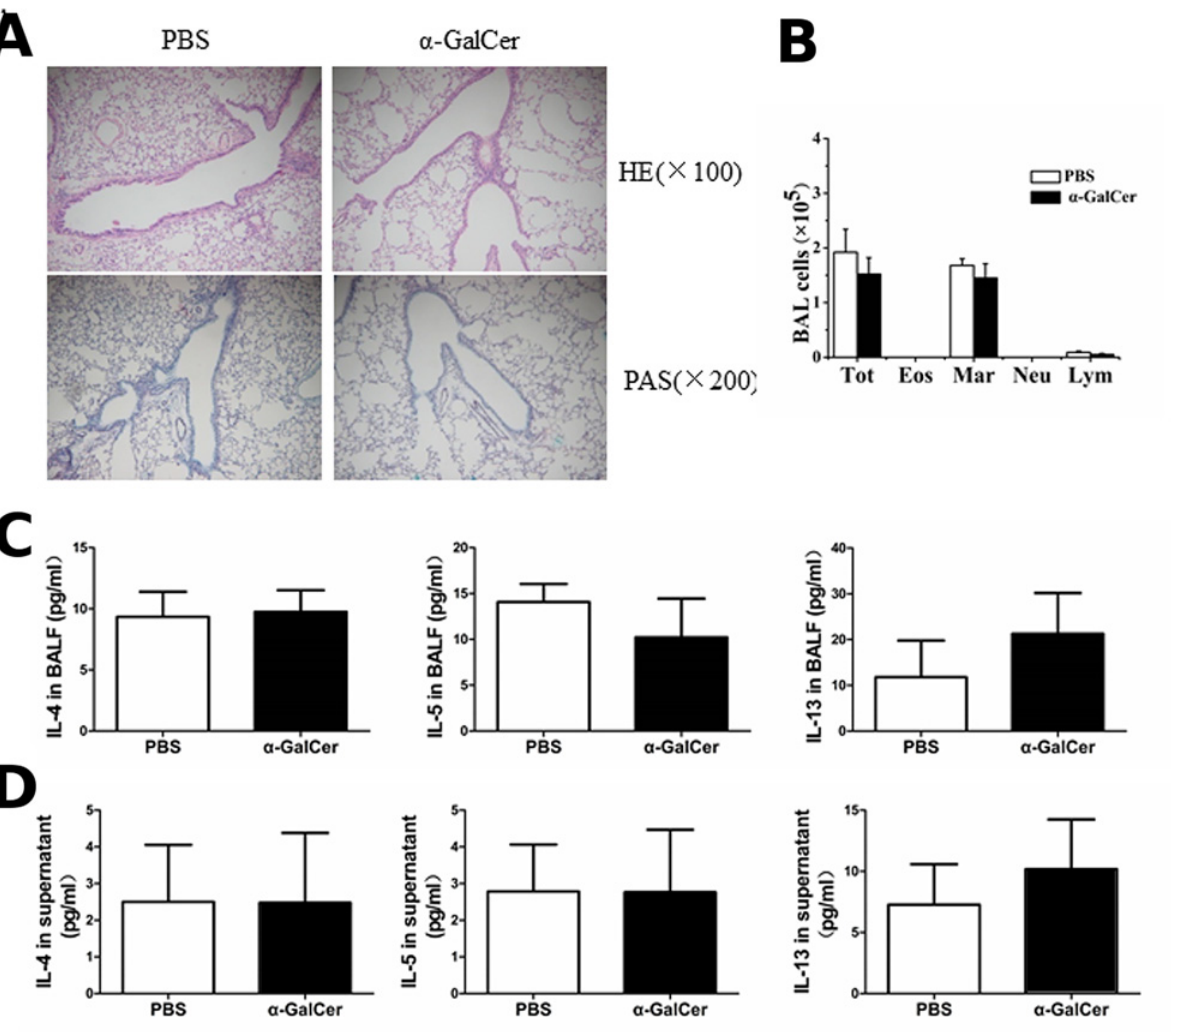
Fig 2. α -GalCer administration cannot induce the Th2 inflammatory response in WT mice. A. Histopathological analysis using the hematoxylin-eosin (H&E) staining and periodic acid-Schiff (PAS) staining of lung tissue sections from mice treated with α -GalCer or PBS. B . Total cell and differential cell counts in the BALF were obtained using a standard hemocytometer. N = 5 per group. Tot, total cell counts; Mar, macrophages; Eos, eosinophils, Neu, neutrophils; and Lym, lymphocytes. C . BALF were collected 3 days after α -GalCer or PBS administration and cytokine (IL-4, IL-5, and IL-13) production was analyzed by ELISA. N = 4 – 5 per group. D . Splenocytes were obtained from mice with α -GalCer or PBS administration and re-stimulated with 500 μ g OVA in vitro . After 72 h, culture supernatants were collected and cytokine production was analyzed by ELISA. N = 5 per